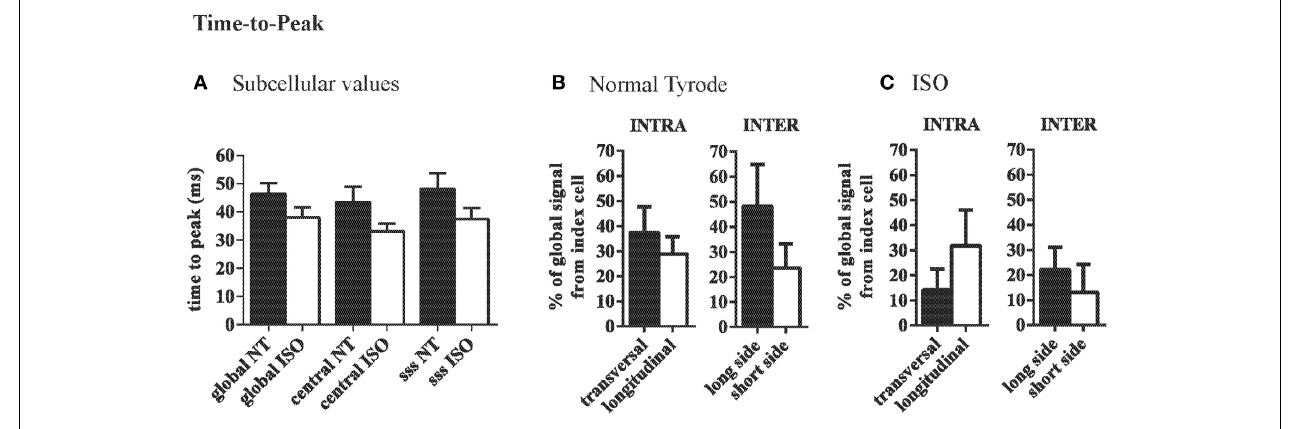
FIGURE 5 | Variation of time to peak Ca is similar across the long and short axis. (A) Average time-to-peak values are comparable throughout a cell and are not significantly changed by ISO. (B) In NT variation of TTP is similar along the transversal